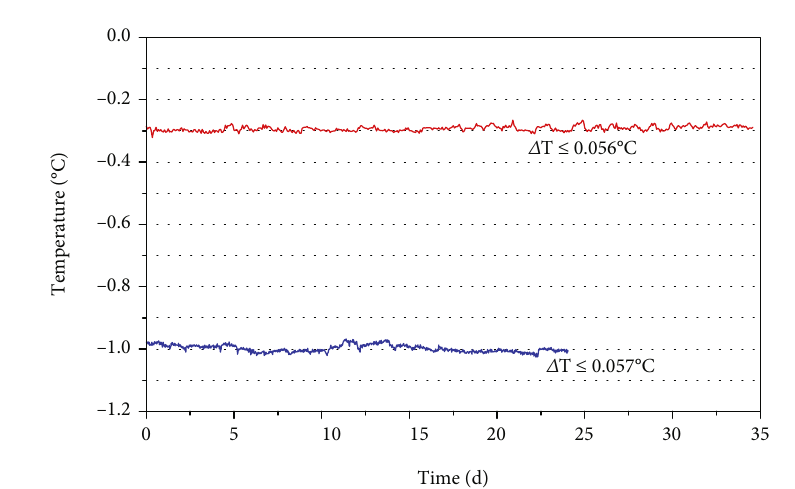
Figure 6: Sample moulding procedure.